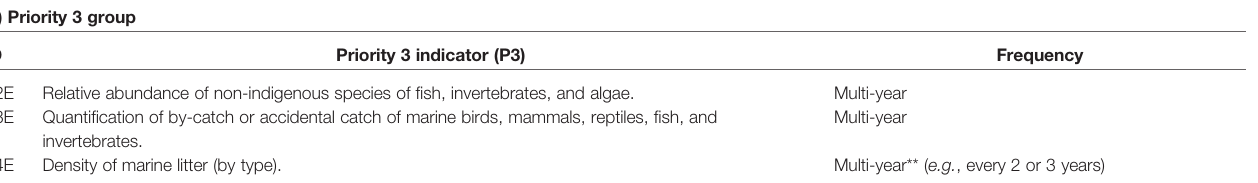
changes for both monitoring themes (in total, three out of 37 indicators changed the priority group).